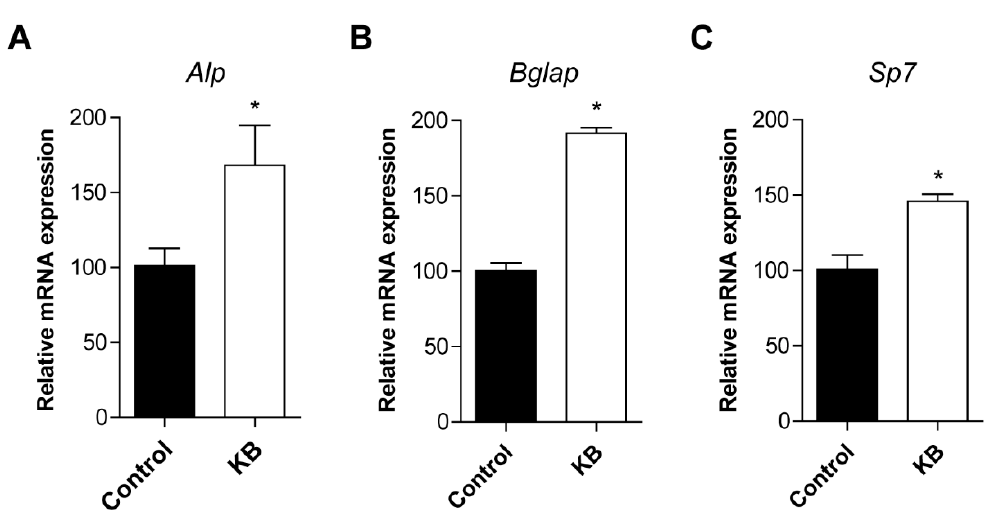
Figure 3. The effects of kukoamine B (KB) on the mRNA expression levels of osteoblastic markers in MC3T3-E1 cells. After the induction of osteoblast differentiation, the cells were treated with 20 μ M of KB. After treatment, the total RNA of the cells was extracted and the mRNA expression levels of Alpl (alkaline phosphatase, ALP) ( A ), Bglap (bone gamma-carboxyglutamate protein, Osteocalcin) ( B ), and Sp7 (Osterix) ( C ) genes were assessed by quantitative reverse-transcription polymerase chain reaction (qRT-PCR). The mRNA levels of the osteoblastic markers were normalized by Gapdh (glyceraldehyde 3-phosphate dehydrogenase) mRNA expression. Control: Non-KB-treated cells. *: p < 0.05 vs. Control (Student’s t-test). All experiments were repeated three times.